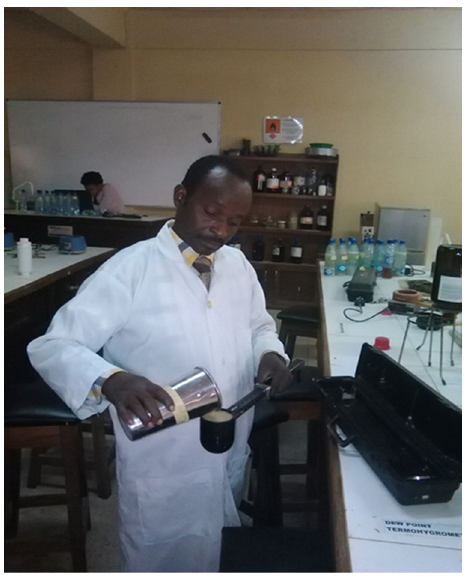
Fig. 6 Magnetic hot plate and stirrer Fig. 7 Density of mud being